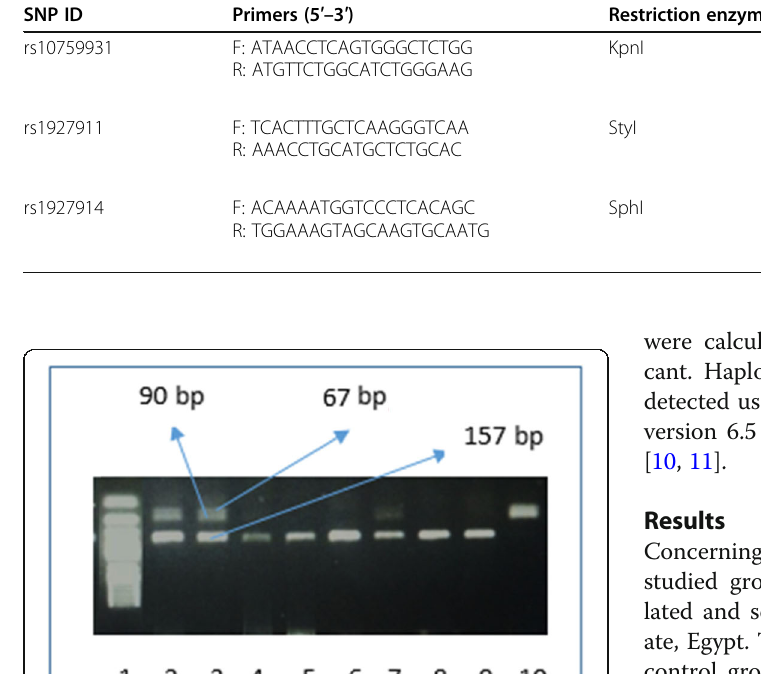
Table 1 Details of RFLP products used in the study SNP ID